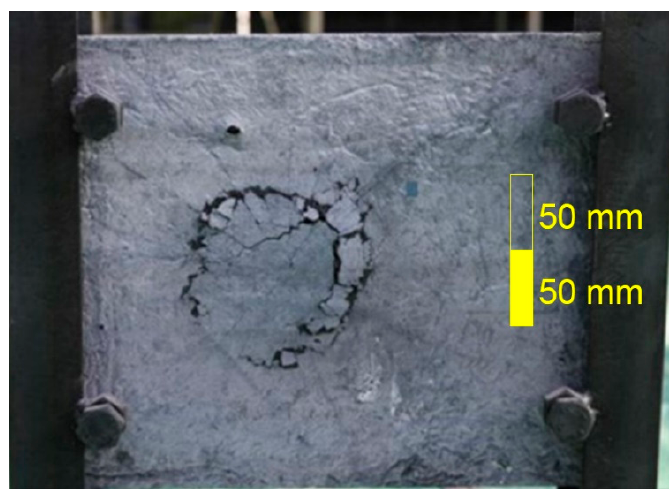
Figure 2. A unique steel frame with the sample.